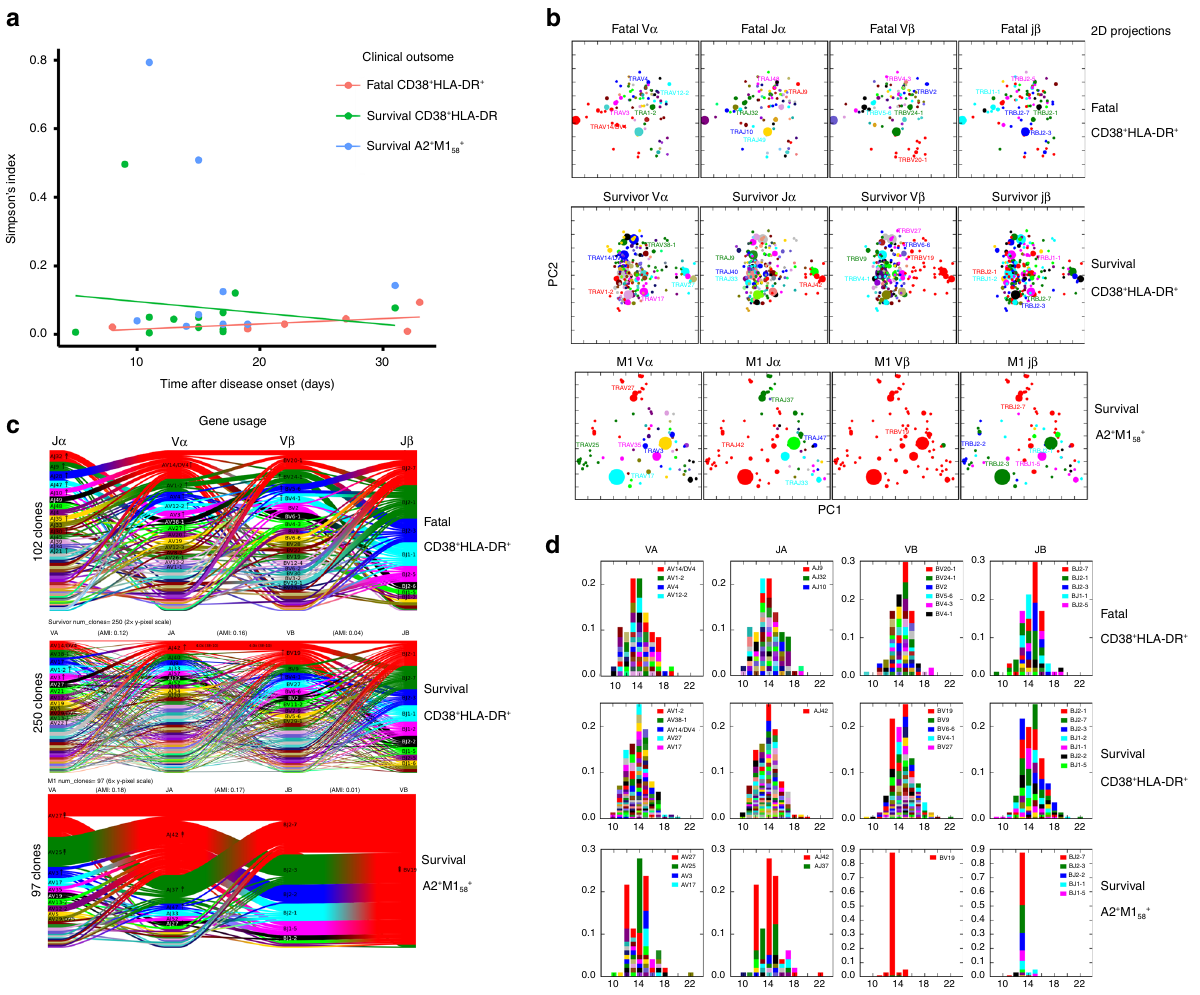
Fig. 5 Distinct clonal expansion patterns within CD38 + HLA-DR + CD8 + T cells in H7N9. Longitudinal single-cell TCR αβ repertoire analysis of CD38 + HLA- DR + CD8 + T cells reveals delayed early clonal expansions within fatal patients. For comparison, TCR αβ characteristics of M1 58 + CD8 + T cells (directed at a single in fl uenza T cell speci fi city) are shown. a Simpson ’ s Diversity Index (SDI) shows differential patterns of TCR αβ clonal expansions longitudinally within CD38 + HLA-DR + CD8 + T cells in patients who survived (in green) and died (in pink). SDIs for survival M1 58 + CD8 + T cells are shown in blue. b Principal component analyses of V α -chain segments, J α regions, V β -chain segments, and J β segments (panels from left to right) were performed to identify increased clustering of TCR αβ elements for survival patients but more distinct TCR signatures for fatal cases, based on TCRdist analysis. The size of speci fi c dot points re fl ects the size of speci fi c TCR genes used. c V and J gene segment usage and pairing landscape is shown by average-linkage dendrogram of TCRdist clusters for J α /V α -chain segments and J β /V β -chain segments (panels from left to right). Segments are colored based on the frequency with which they occur within the repertoire with a color sequence, beginning with red (most frequent), then green (second most frequent), blue, cyan, magenta, and black. d CDR3 length against prominent V α -chain segments, J α regions, V β -chain segments, and J β regions is shown for CD38 + HLA- DR + CD8 + T cells within both the surviving and fatal H7N9 patients, as well as M1 58 + CD8 + T cells within the surviving patients. The left right ordering of the segment types is chosen so that VA and JA are on the left, VB and JB are on the right, and the alpha – beta pairing with the largest adjusted mutual information is in the